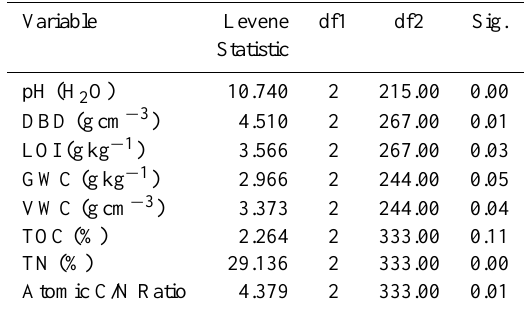
Table 9. Test of Homogeneity of Variances in Drainage Groups. Table 10. Robust Tests of Equality of Means of Research Variables in Drainage